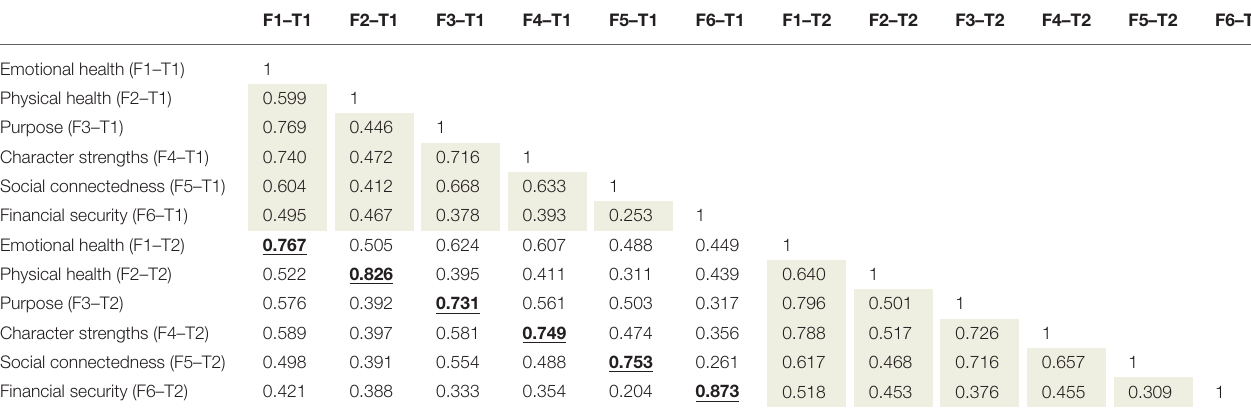
Bolded and underlined numbers are test–retest correlations. Gray cells in the upper five rows present correlation coefficients among the six WBA domains at T1. Gray cells in the lower five rows present correlation coefficients among the six WBA domains at T2. All correlation coefficients are significant at p < 0.001. WBA, Well-Being Assessment.